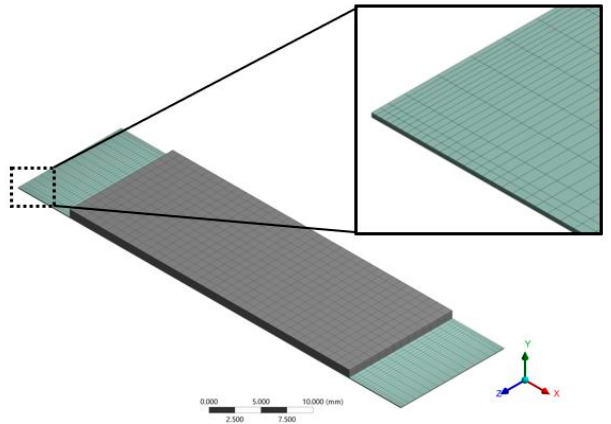
Figure 6. View of the mesh used in the finite element method (FEM) models of the piezoelectric nanogenerator. Table 3. Properties of the piezoelectric nanogenerator used in the analytical and finite element method (FEM) models [44].